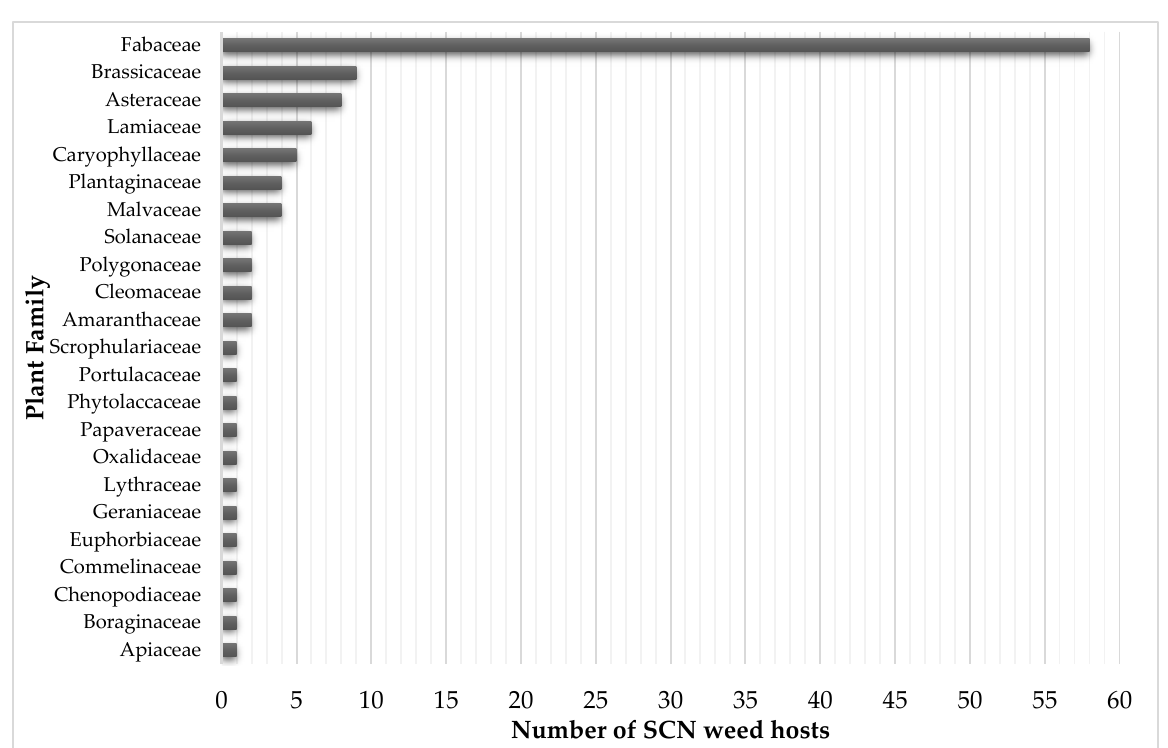
Figure 3. Number of weed species hosting SCN per plant family from a total of 116 species listed in Table 1.